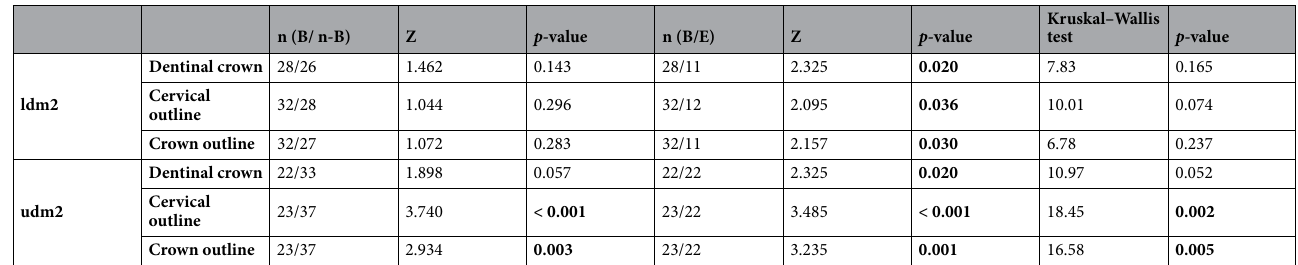
Table 4. Results of the Mann–Whitney U test and Kruskal–Wallis test. Differences in dental sizes (expressed by the logarithm of Centroid Sizes) for the deciduous upper and lower second molars (udm2 and ldm2, respectively) between the Baka and the rest of the comparative sample, between the Baka and the Europeans, and among all populations across the sample (B = Baka; n-B = non-Baka; E = Europeans; N = number of